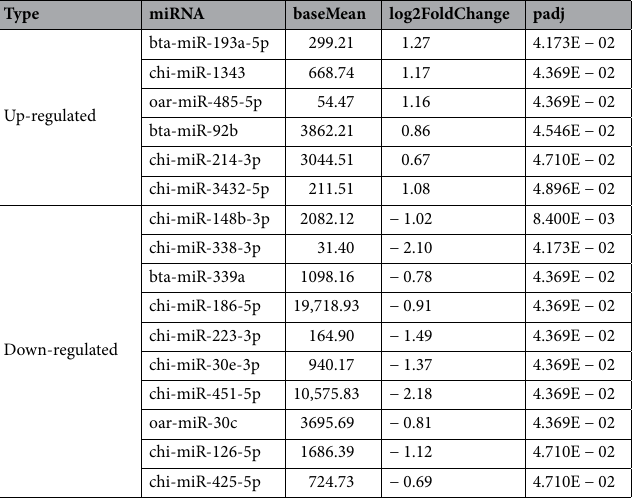
Table 2. Differentially expressed miRNAs in the Adj vs. Control comparison. baseMean: average of the normalized DESeq2 count values.